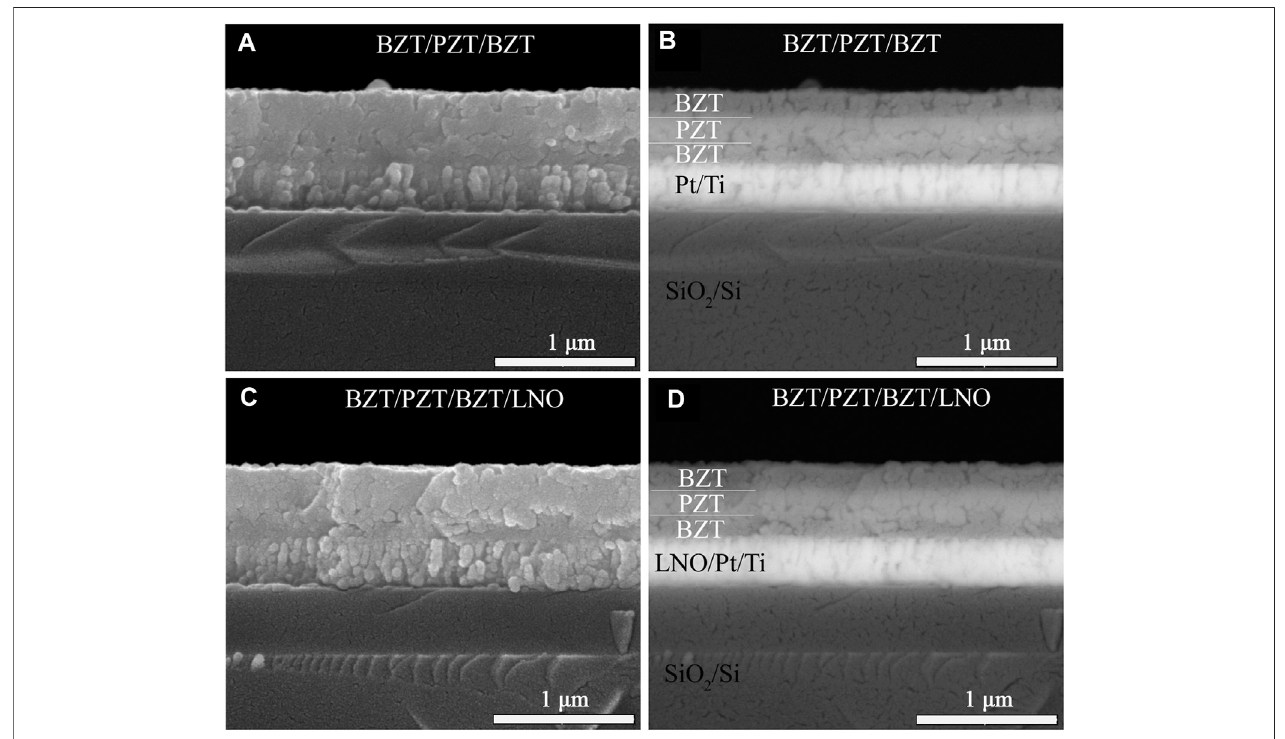
FIGURE 3 | Cross-sectional images of the BZT/PZT/BZT and BZT/PZT/BZT/LNO thin fi lms. (A, C) SEM images; (B, D) BSE images.